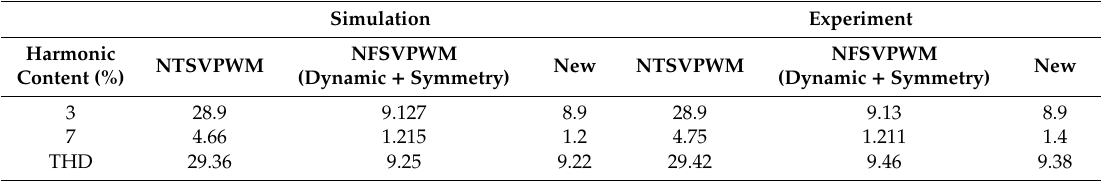
Table 4. Simulation and experimental data for m =